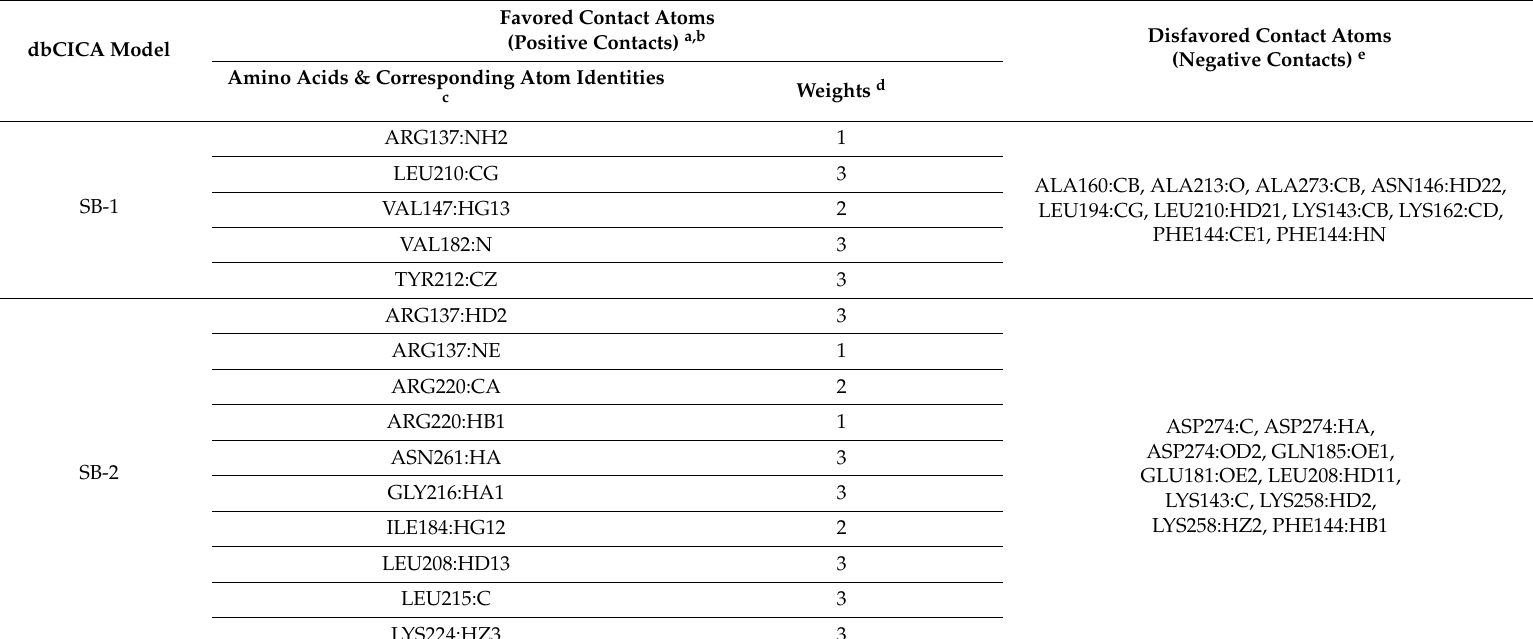
Table 2. Critical Binding Site Contact Atoms Proposed by Optimal dbCICA